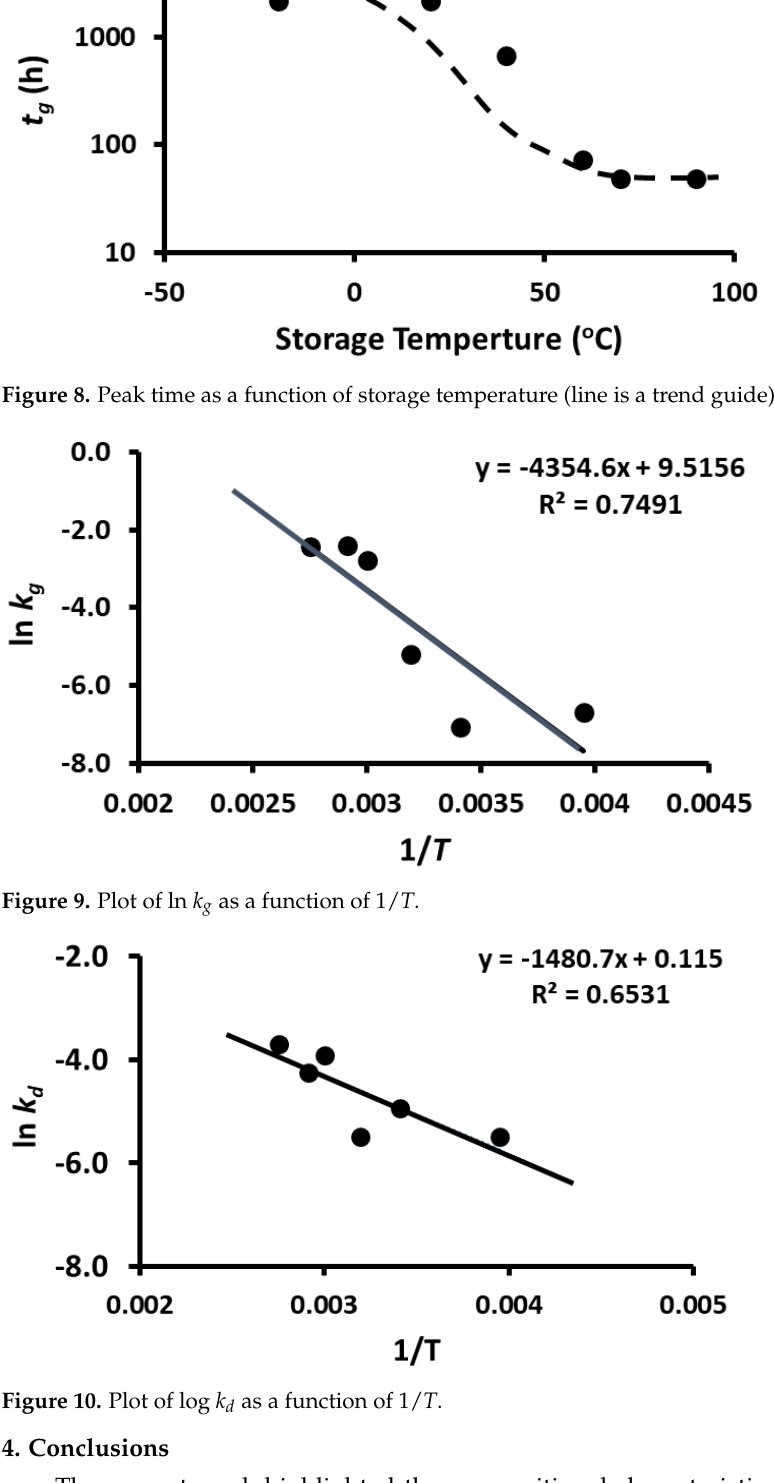
Figure 10. Plot of log k d as a function of 1/ T.